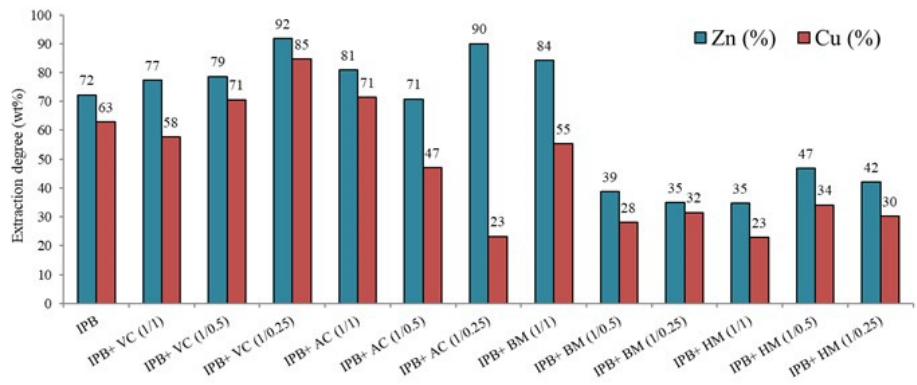
Figure 2. Extraction degree (wt%) of Zn and Cu.